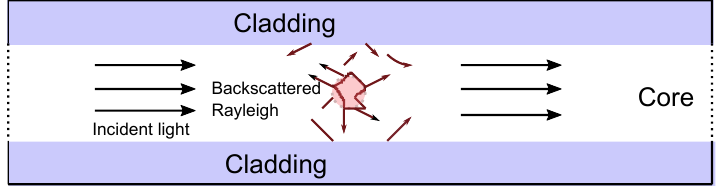
Figure 4. Schematic of a spontaneous Rayleigh backscattering process through the core of an optical fiber cable. (Adapted from